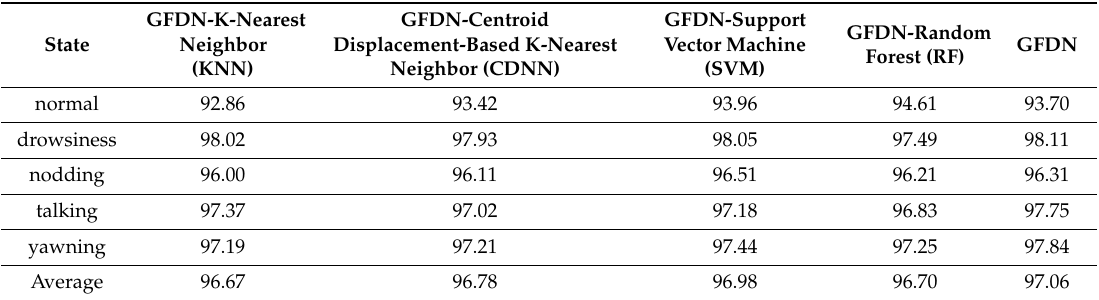
Table 2. Drowsiness detection accuracies (%) for di ff erent states of the NTHU-DDD dataset in GFDN and derived models.